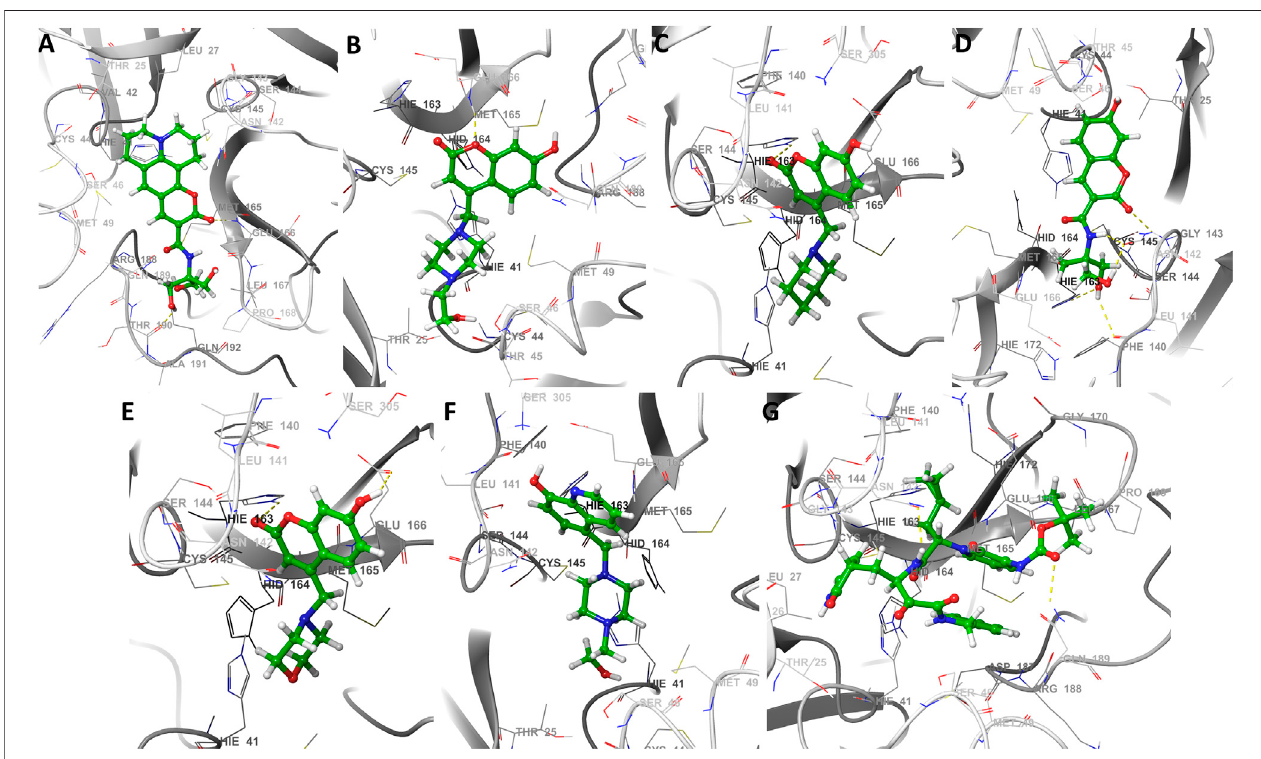
FIGURE 2 | The best seven docking poses of different ligands in SARS-CoV-2 M pro binding pocket. Snapshots of (A) CTR6, (B) 7HC6, (C) 7HC5, (D) CTR9, (E) 7HC3, (F) 8HQ6 and (G) 13b during docking simulations. The yellow dotted line usually represents intermolecular interactions, like hydrogen bonds.